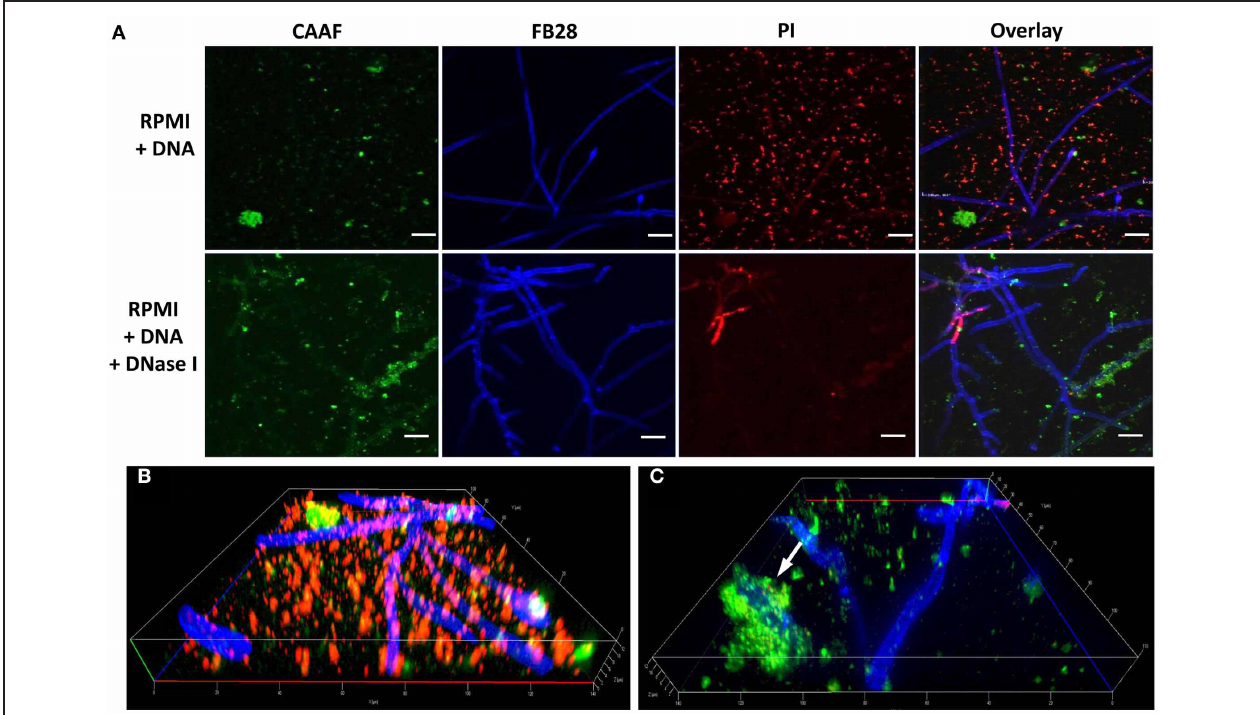
FIGURE 7 | Polysaccharides provide the main stability in early DNA induced biofilms. Biofilms were grown with DNA over a time of 24h and DNase I was added during early biofilm development (bottom panel). (A) Biofilms were imaged by CLSM after staining with CAAF for polysaccharides, with fluorescence brightener (FB28) for chitin and PI for DNA. White bars indicate 20 μ m. Note that DNase I treatment